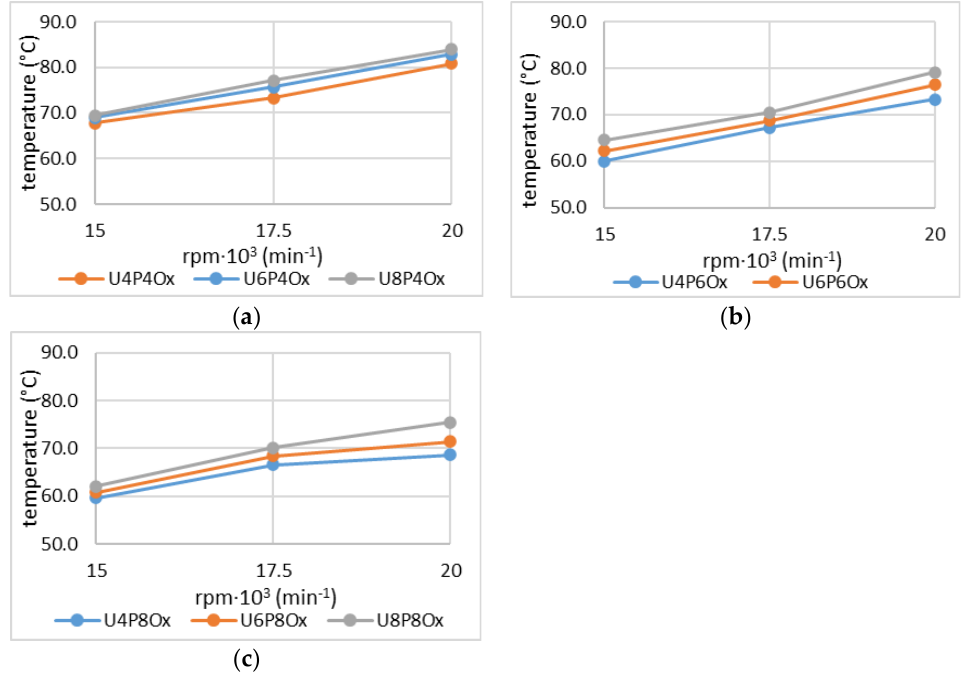
Figure 8. Dependence of the temperature change in the tool on the radial depth of cut and revolutions (( a ) — feed speed-4 m.min -1 , ( b ) — feed speed-6 m.min −1 , ( c ) — feed speed 8 m.min −1 ). Table 3. The value of the correlation coefficient r xy between the machine parameters and the measured temperature and noise